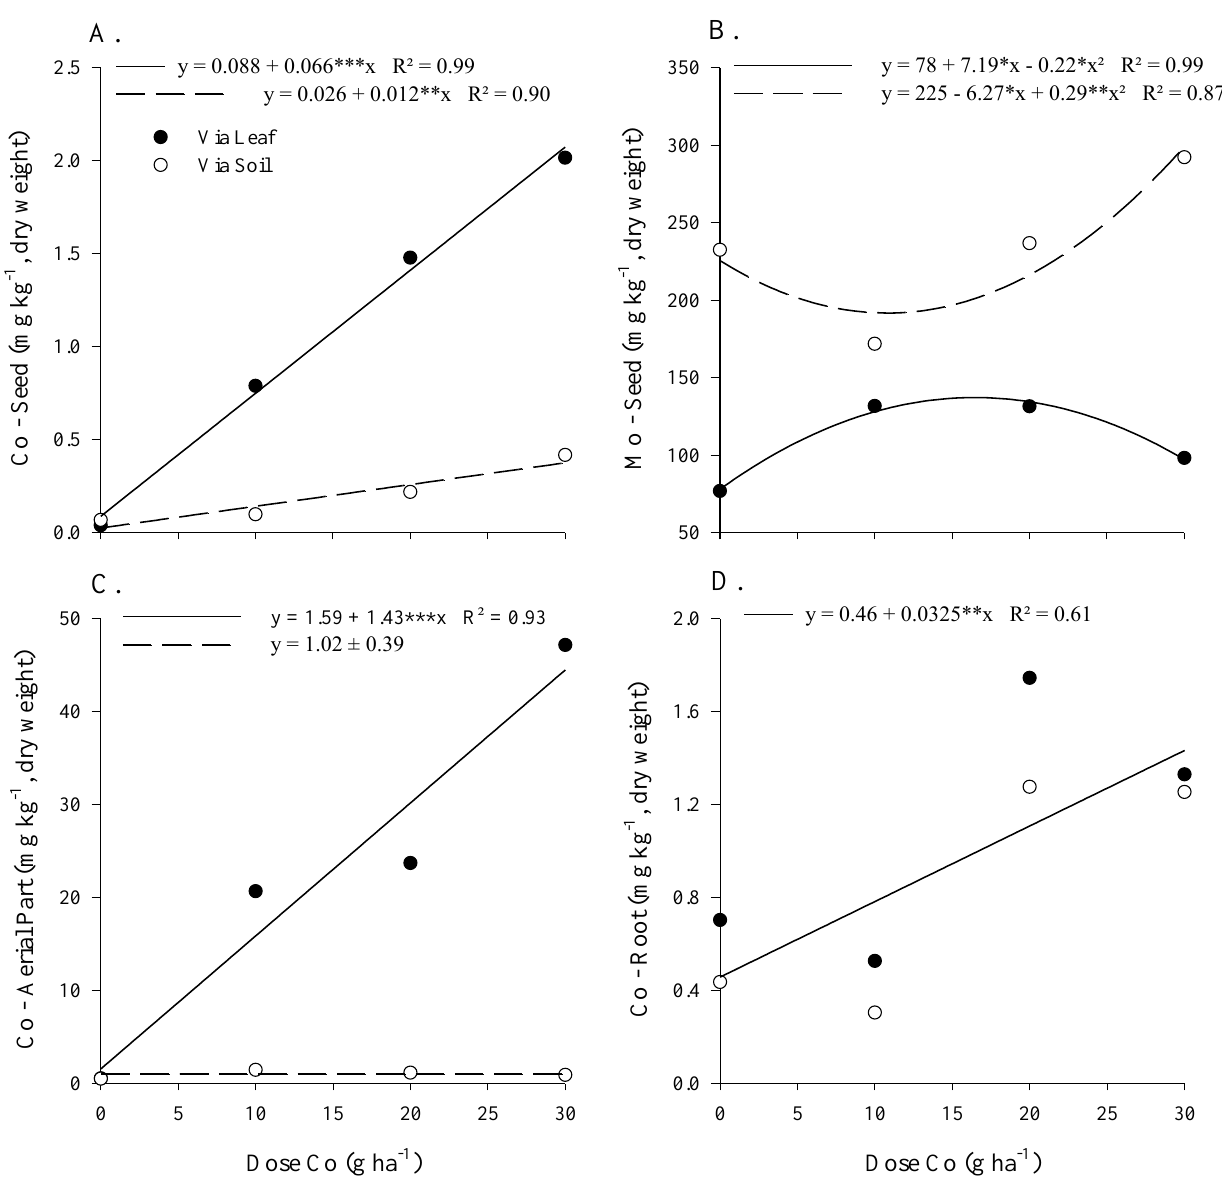
Figure 1. Cobalt and Mo concentration in seed ( A , B ) and Co in aerial part ( C ) and soybean roots ( D ) as a function of Co doses, with 800 g ha −1 Mo, via leaf and via soil application in soybean parent plants, in the maturation phase. *, **, ***-Significant at 0.05, 0.01, and 0.001 by t -test. There was a higher Mo concentration in the seed with soil application than when foliar application was used; both forms of the application being higher than the control without Co and Mo application (Table 1). The highest Mo concentration in soybean seed was 134 mg kg −1 at a dose of 16.3 g ha −1 of Co applied via foliar application (Figure 1B). Starting at a dose of 10.8 g ha −1 of Co applied by soil, there was an increase in the Mo concentration in soybean, reaching a maximum of 298 mg kg −1 in the dose of 30 and 800 g ha −1 of Co and Mo (Figure 1B). The Mo concentration in the soybean shoots was 4.3 times higher under foliar appli- cation than by soil, with both applications providing a higher concentration than the con- trol (Table 1). The Mo concentration in the roots and soil were 1.1 and 0.78 mg kg −1 when applied foliarly and 76.7 and 3.68 mg kg −1 when applied by soil, respectively. Both com- partments showed Mo concentrations equal to the control when the foliar application was made.